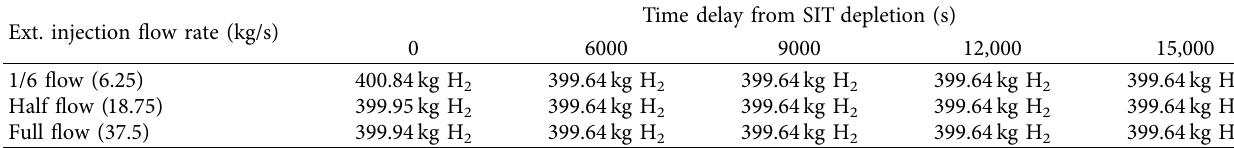
Table 9: Effect of external injection flow rate and time delay (depressurization at core